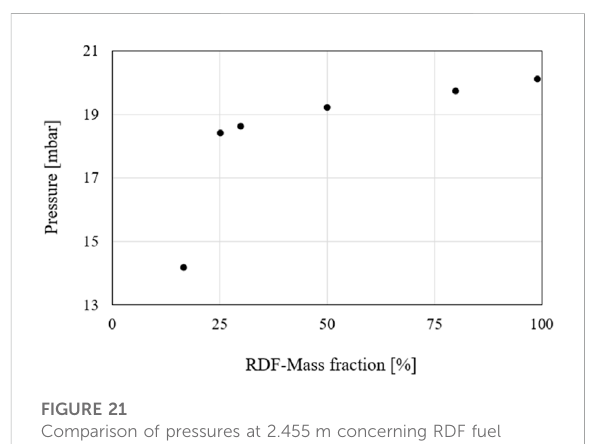
FIGURE 21 Comparison of pressures at 2.455 m concerning RDF fuel mass fraction.